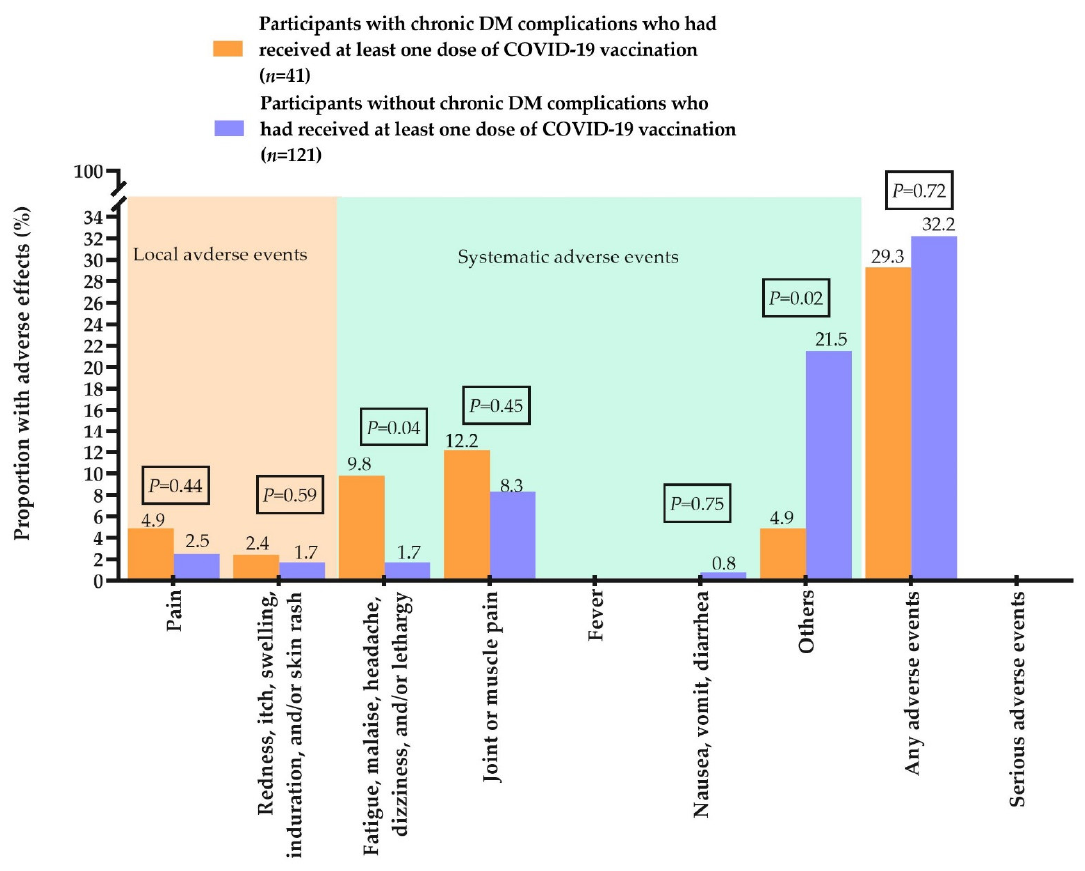
Figure 2. Adverse effects after vaccination.